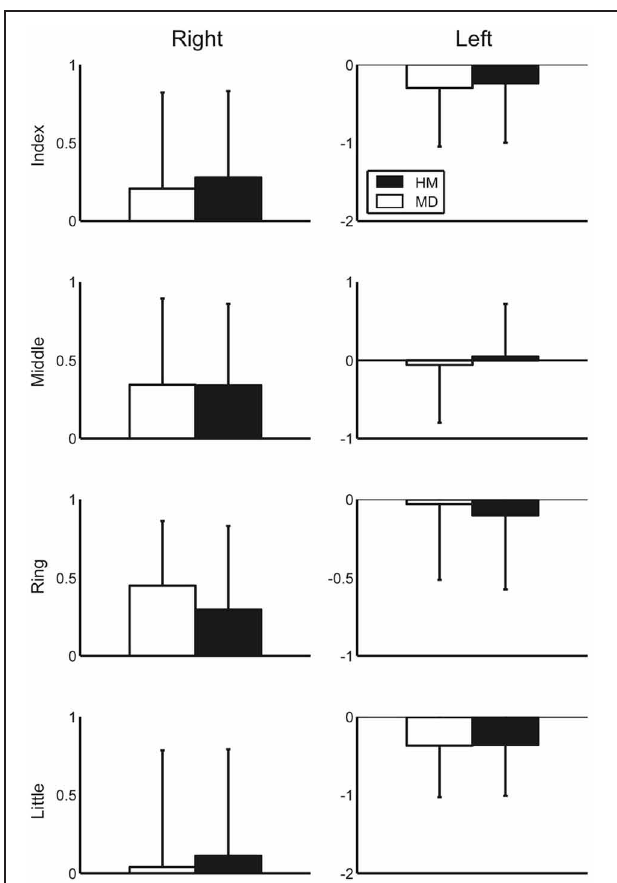
FIGURE 2 | A group mean of the logarithmic-transformed and standardized perceptual value at the external stimulus condition at each of the four fingers at the right (left panel) and left (right panel) hands across healthy musicians (HM) and musicians dystonia (MD). Error bar indicates one standard deviation across participants.